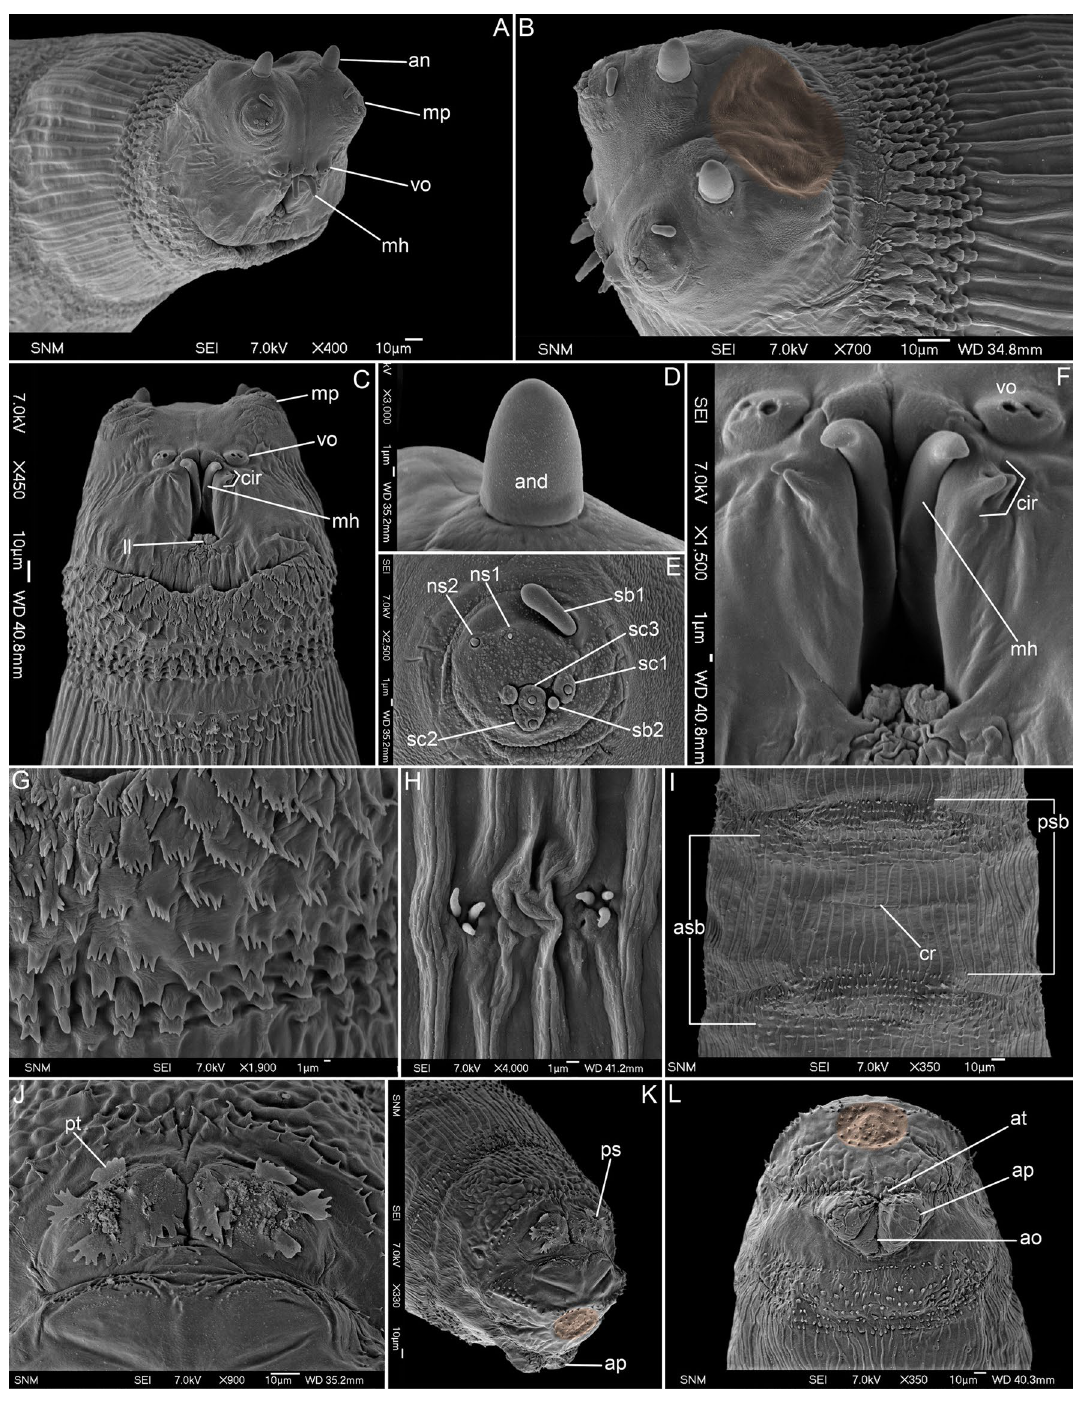
Figure 3. First instar larva of Protomiltogramma cincta . ( A ) Anterior end, antero-lateral view. ( B ) Anterior end, dorsolateral view. ( C ) Anterior end, ventral view. ( D ) Antennal complex. ( E ) Maxillary palpus. ( F ) Mouth opening. ( G ) First thoracic segment, ventral view, anterior spinose band. ( H ) First thoracic segment, Keilin’s organ. ( I ) Second abdominal segment, ventral view. ( J ) Posterior spiracles. ( K ) Posterior end, postero-lateral view. ( L ) Posterior end, ventral view. Circular depression on pseudocephalon and anal division is highlighted in brown. an, antennal complex; and, antennal dome; ao, anal opening; ap, anal papilla; asb, anterior spinose band; at, anal tuft; cir, cirri; cr, transverse crevice; ll, labial lobe; mh, mouthhook; mp, maxillary palpus; ns1, first additional sensillum coeloconicum; ns2, second additional sensillum coeloconicum; ps, posterior spiracle; psb, posterior spinose band; pt, peristigmatic tuft; sb1–3, sensilla basiconica 1–3; sc1–3, sensilla coeloconica 1–3; vo, ventral